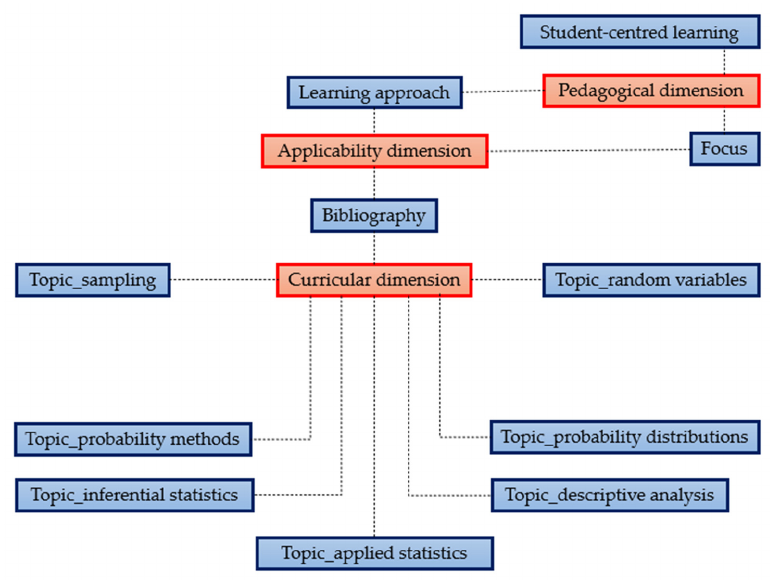
Figure 2. Relationship between the three dimensions of the analysis and the 11 code groups. The red nodes represent the three dimensions (emergent categories) and all other nodes represent groups of codes. This scheme comes from a first coding system of 65 codes, which is shown in Appendix A.